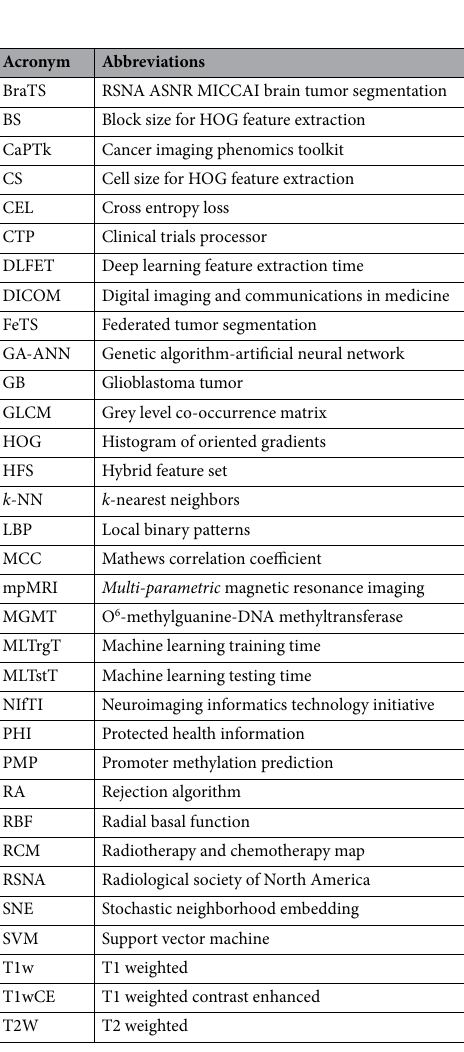
Table 1. Abbreviations with acronyms used in the